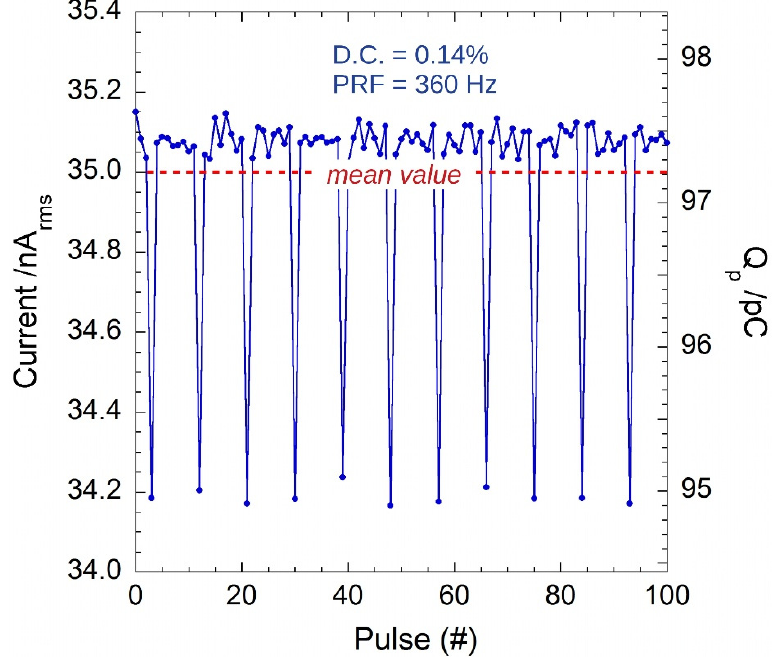
Figure 7. Rms current and charge-per-pulse calculated according to Equations (8) and (10) for pulses generated by the Keithley 6221 at 360 Hz. The effect of Δ t not exactly equal to 4 µs is corrected by the 6221 instrument by adjusting the peak amplitudes on 9 pulses to give the programmed mean value of the effective current (red dashed line).